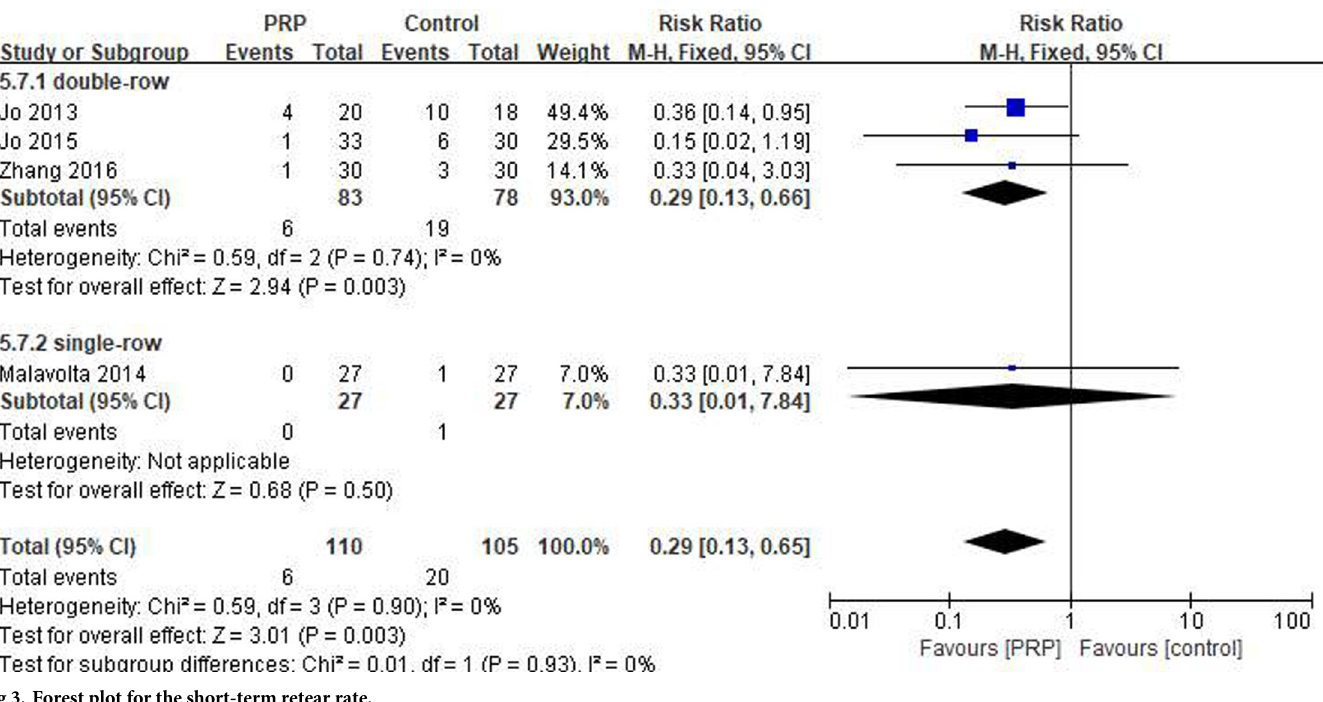
Fig 3. Forest plot for the short-term retear